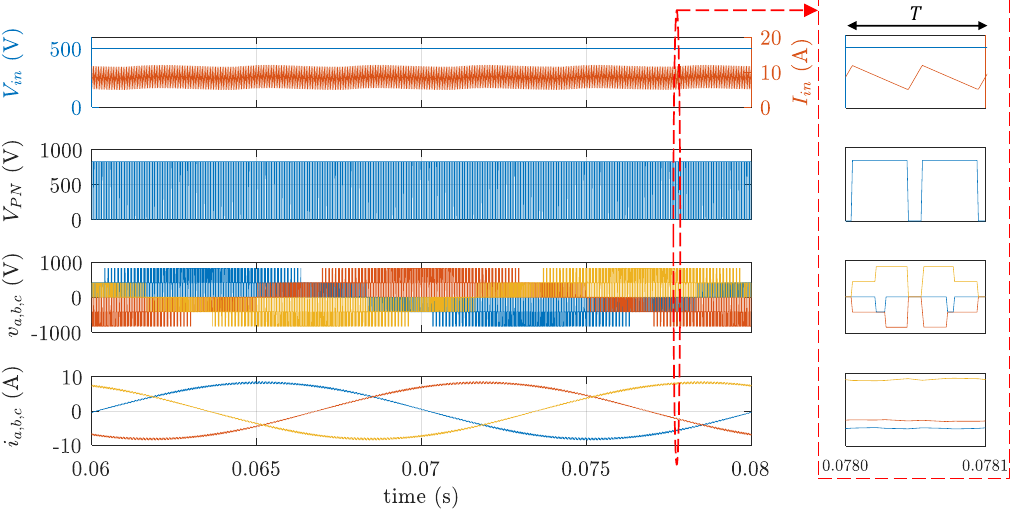
Figure 8. Simulation results for the FST strategy, switching frequency 10 kHz, m = 0.8, and D S = 0.2. Top to bottom: input voltage ( V in ) and input current ( I in ); DC-link voltage ( V PN ); and line-to-line voltages before filtering ( v ab , v bc , and v ca ) and output currents ( i a , i b , and i c ). Right: zoomed views for one switching cycle.